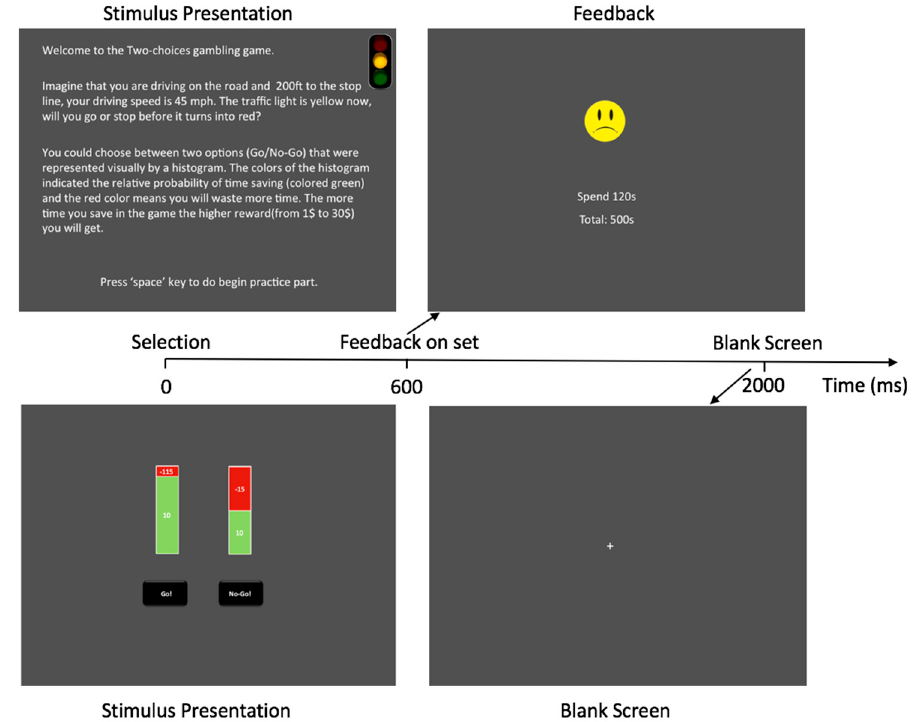
Figure 1. Presentation of the experiment. Note: Description of one trial: the participants chose to Go or No-Go, and after 600 ms, the feedback (the positive feedback is time-saving with a smiling face, whereas the negative feedback is time waste along with a sad face) was at the onset and lasted to 2000 ms. Thereafter, a blank screen emerged, and then a new trial began.